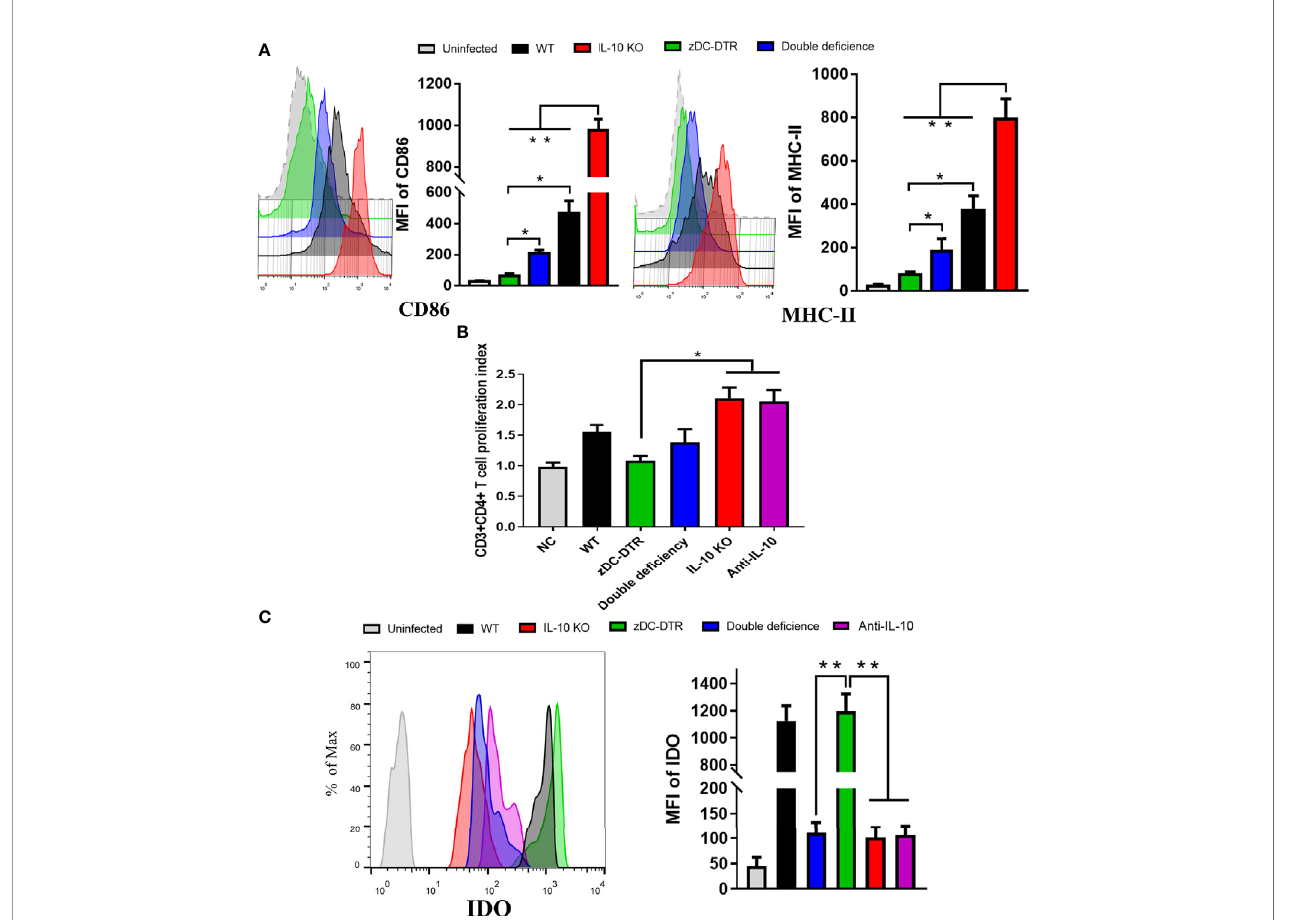
FIGURE 5 | DCs maturation, T cell proliferation, and IDO expression in the co-culture system. (A) Flow cytometry detection of CD86 and MHC-II DC surface markers; mean fl uorescence intensity (MFI) was calculated at 72 hpi. CD86 and MHC-II were analyzed by pre-gated CD11c + cells, CD11c was gated by isotype. CD86 and MHC-II surface markers were signi fi cantly upregulated in the co-culture system of CD4 + T cells and IL-10 − / − DCs. Compared to the DCs from the zDC-DTR group, CD86 and MHC-II were signi fi cantly higher in the DD group. (B) Measurement of CD4 + T cell proliferation via BrdU assay in the co-culture system of CD4 + T cells and DCs at 72 h. Higher CD4 + T cell proliferation was observed in the IL-10 − / − and anti-IL-10 groups than the zDC-DTR group ( P <0.05). There were no statistically signi fi cant differences observed between the DD, IL-10 − / − , and anti-IL-10 groups. (C) Flow cytometry detection of IDO expression; MFI was calculated at 72 h. Signi fi cantly increased IDO expression was observed in BMDCs from the zDC-DTR and WT mice. Differences were analyzed by ANOVA (* P <0.05, ** P